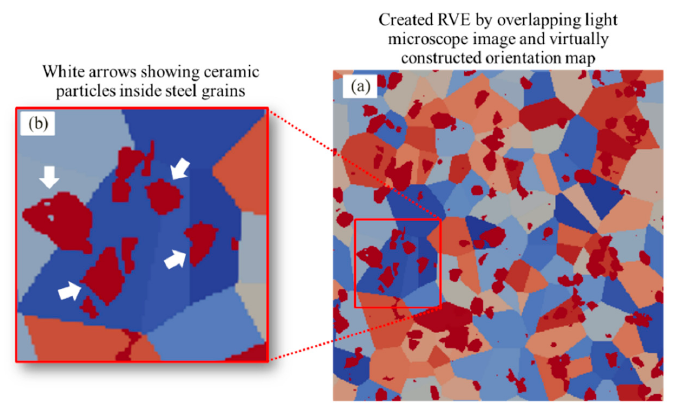
Figure 3. The issue with the generated represented volume element (RVE) microstructure using the overlapping technique: ( a ) constructed geometry file with phase and orientation information; and ( b ) white arrows highlighting the MgO-PSZ particle present inside steel grains.